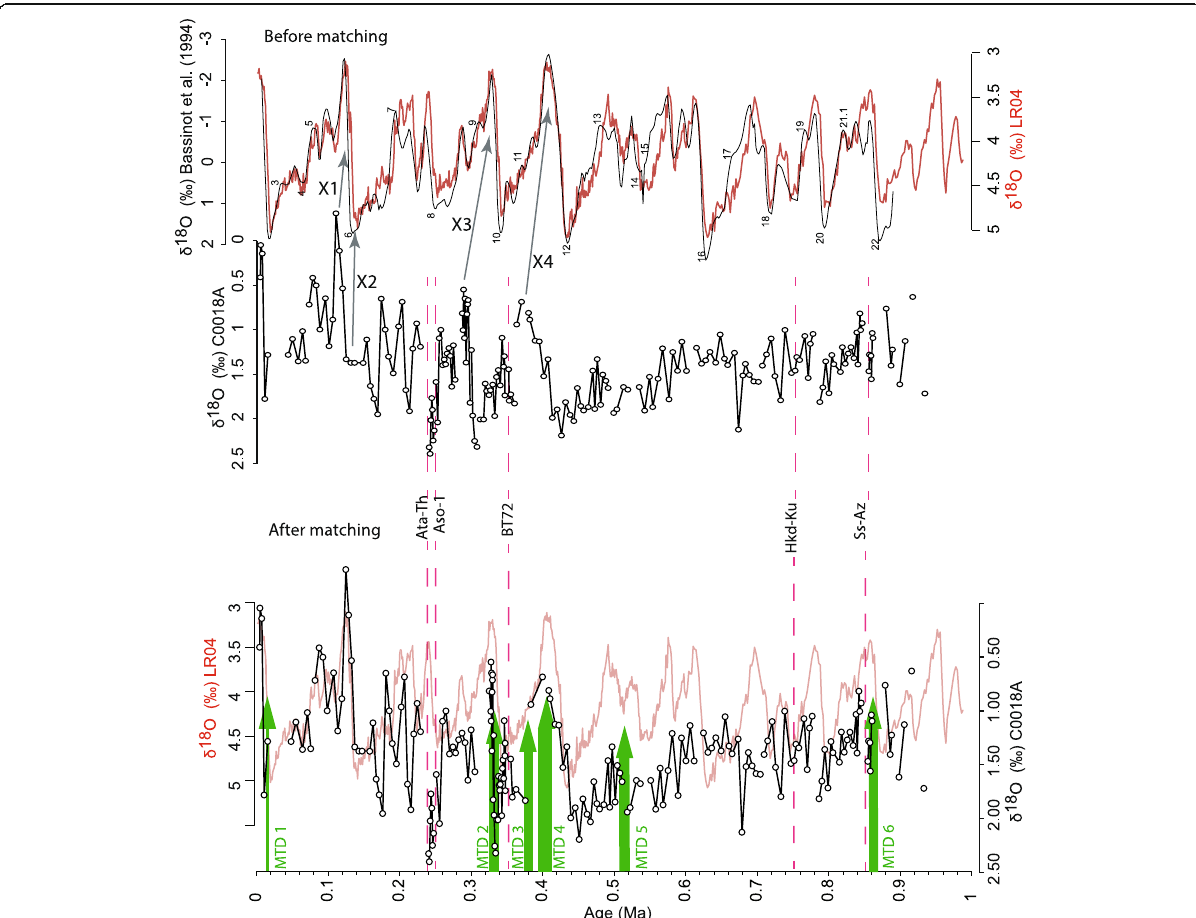
Fig. 7 Core C0018 δ 18 O profile as a function of age based on tephrochronology and the LR04 stack (Lisiecki and Raymo 2005) before and after matching. The dataset from Bassinot et al. (1994) is shown in black . The gray arrows between the two curves indicate the timing of the matching points (X1 – X4). The pink dotted lines indicate the dated tephras used as time markers for the correlation. Green arrows indicate MTDs. MIS stages are from Bassinot et al.